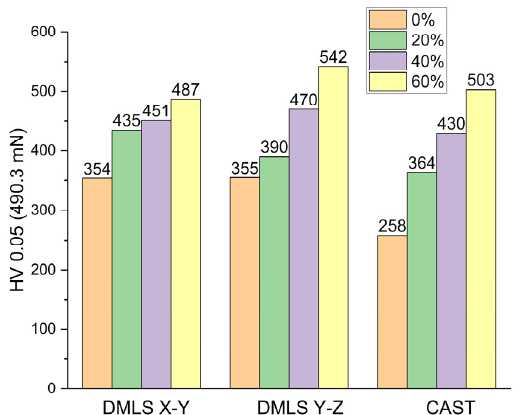
Figure 9. Microhardness of DMLS and as-cast samples.